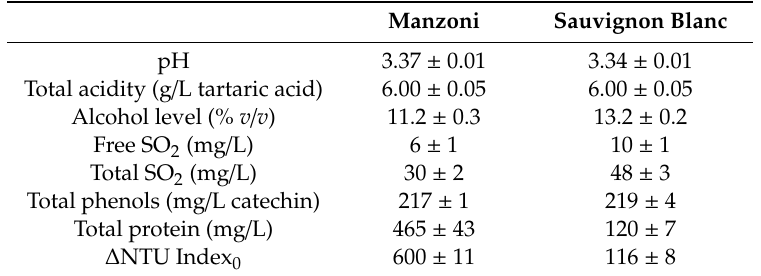
Table 1. Oenological parameters of the unfined Manzoni and Sauvignon Blanc